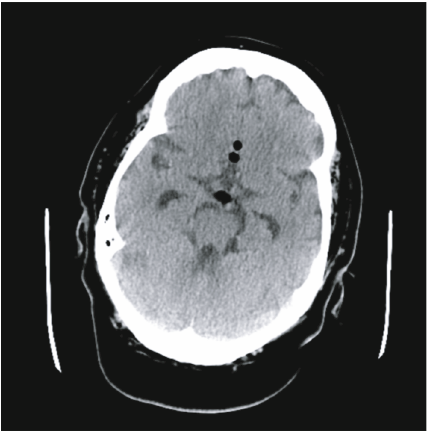
Figure 1: Brain scan demonstrating beginning of pneumocephalus.